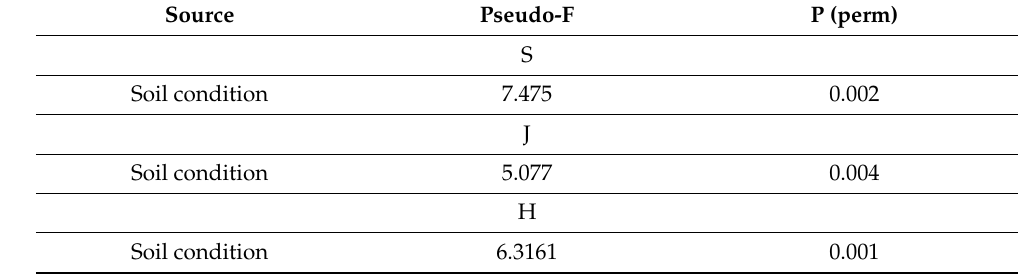
and 2.33 ± 0.1, for M + L and M + NL, and J of 0.79 ± 0.02 and 0.85 ± 0.02, for M + L, respectively). In contrast, the lowest H and J values were detected in the NM + L plots (0.72 ± 0.01 and 1.90 ± 0.05, respectively), and these indexes were very close to the values that were detected in the control soils (H of 1.94 ± 0.65 and J of 0.78 ± 0.26) (Figure 3). Table 4. Results of the PERMANOVA that was applied to the three indexes (S, species richness; J, Piélou; and H, Shannon) to measure the plant species diversity under five soil conditions (different post-fire treatment) in the experimental site (Liétor, Castilla La Mancha, Spain). Source P (perm)